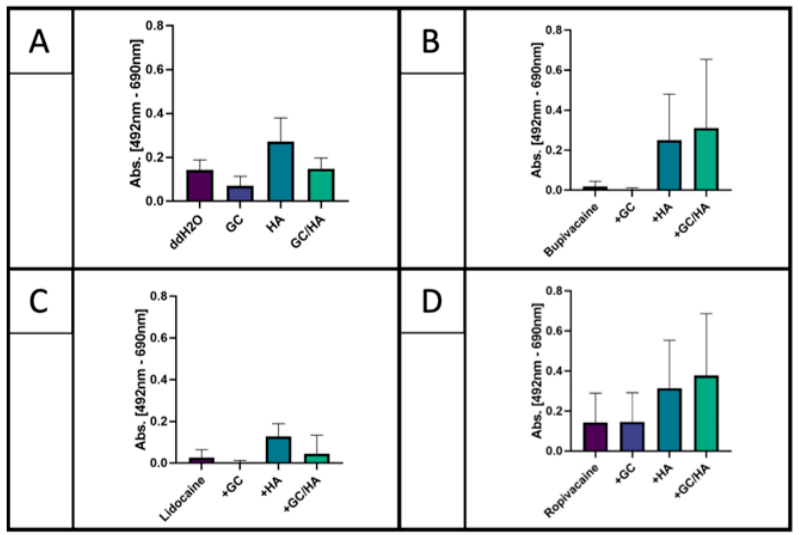
Figure 4. Metabolic activity of test substances in a single dose ( A ) as well as treating cells with LA alone and combined with test substances and LA ( B ) bupivacaine, ( C ) lidocaine, ( D ) ropivacaine. All the results showed no significance between respective groups. the results showed no significance between respective groups.